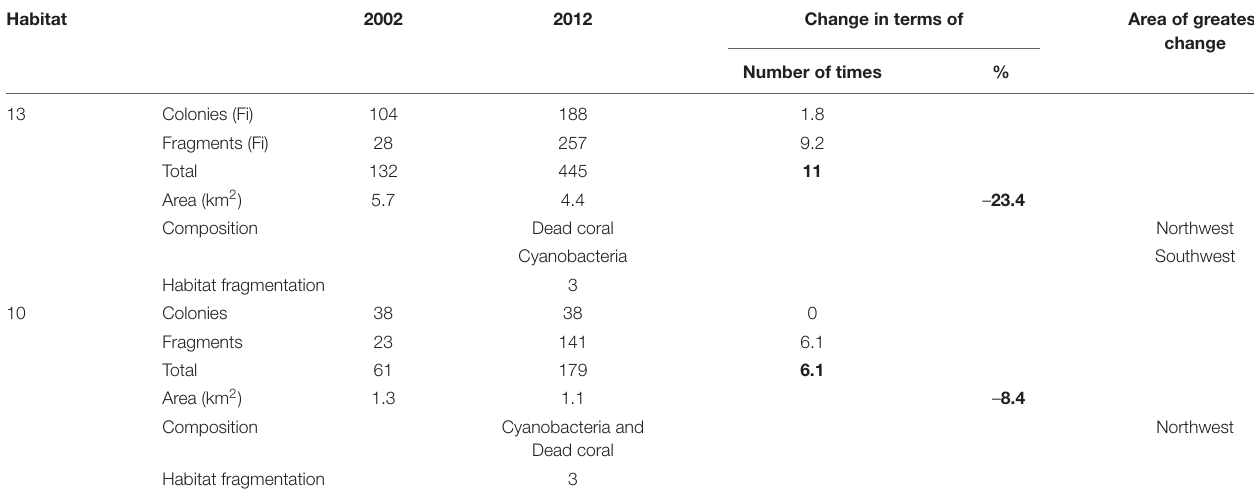
TABLE 3 | Relationship between D. cylindrus population and habitat change (bold).